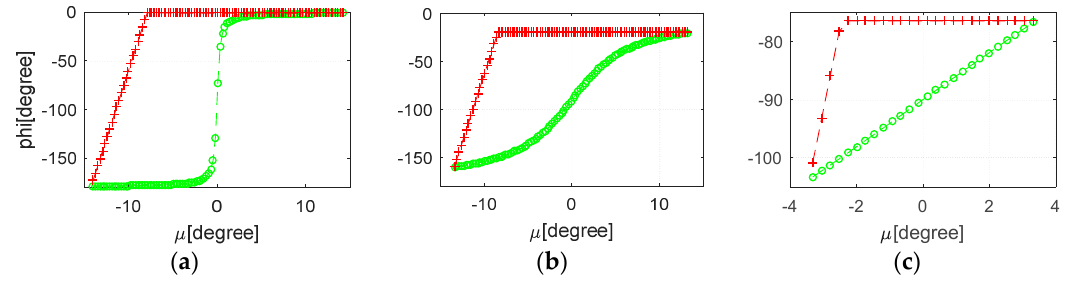
Figure 6. The yaw angle of R10 (M) during shadow crossing for different sun angles: ( a ) beta = 0.24°; ( b ) beta = 4.77°; and ( c ) beta = 13.79°. The nominal yaw angle is shown in green, while the modeled one is in red.